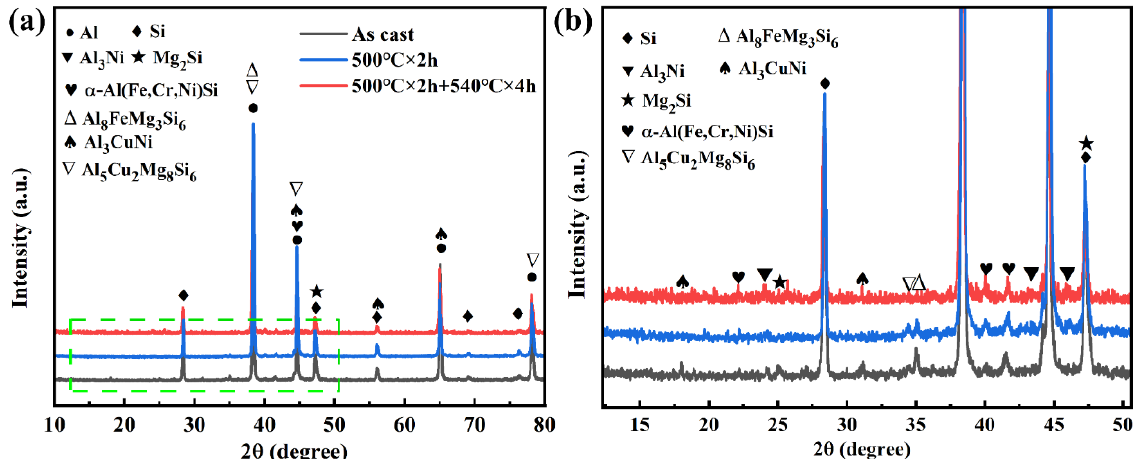
Figure 4. XRD patterns of the alloys: ( a ) at different states, ( b ) enlargement of the boxed area in ( a ).